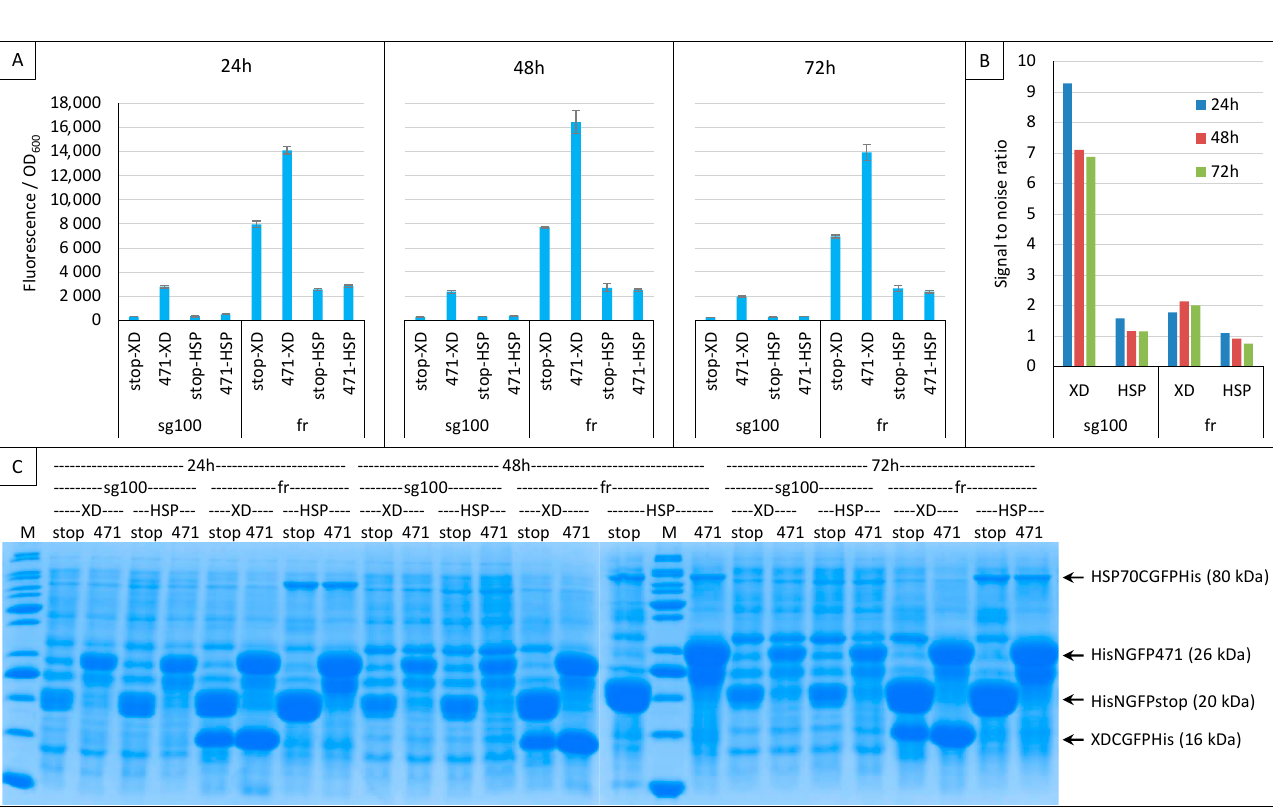
Figure 11. Low-affinity interactions. Split-GFP reassembly assay results as obtained at 24, 48 and 72 h with sg100 and fr GFP reporters and with negative (stop) and positive (471) controls of the 471/XD interactions at 17 ◦ C. The sg100 experiments used non-His-tagged CGFP fusions, whereas fr experiments used His-tagged CGFP fusions. ( A ) Fluorescence to OD 600 ratios. NGFP (stop, 471) and CGFP (XD, HSP) combinations are indicated on the x-axis. ( B ) Signal-to-noise ratio of the data in A. ( C ) SDS-PAGE analysis of the expression of the NGFP and CGFP fusions. M, molecular size markers (200, 150, 100, 85, 70, 60, 50, 40, 30, 25, 20, 15, 10 kDa).